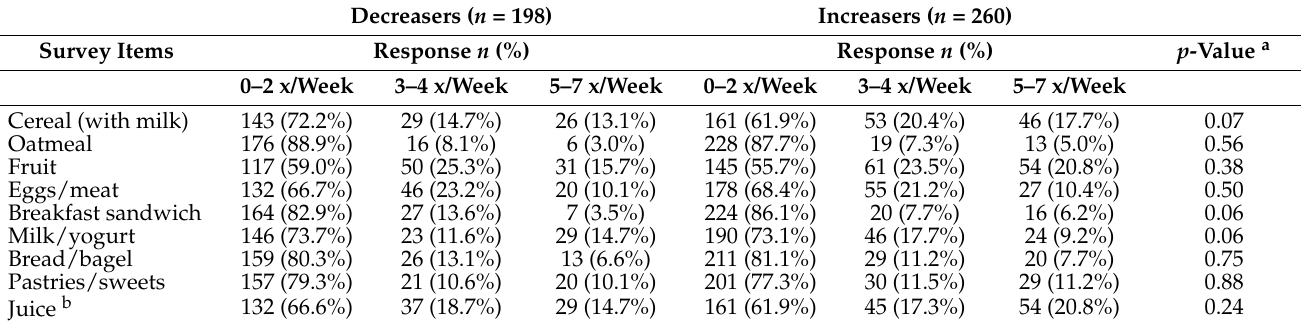
Table 5. Chi-square examining consumption frequencies of breakfast food items in predominately low-income children by breakfast consumption